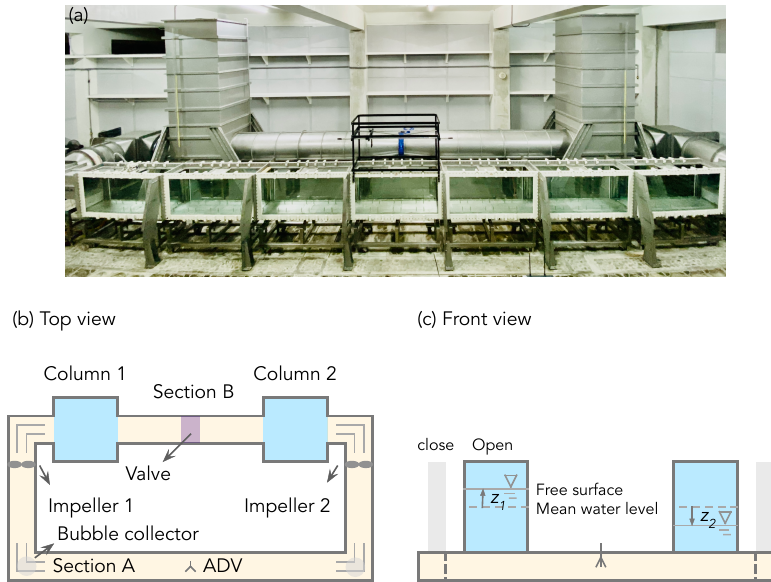
Figure 1. The O/U-tube. ( a ) Photo. Schematic illustration: ( b ) top view and ( c ) front